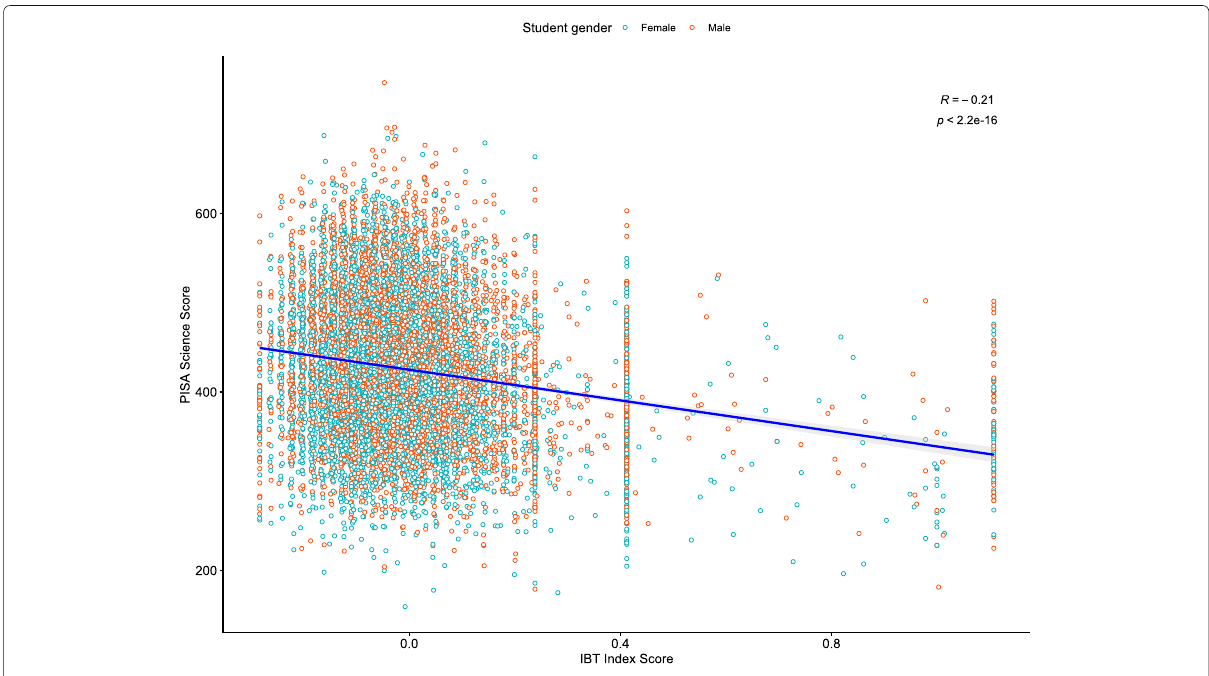
Fig. 5 Association between IBT and the science scores of Colombian students in PISA 2015